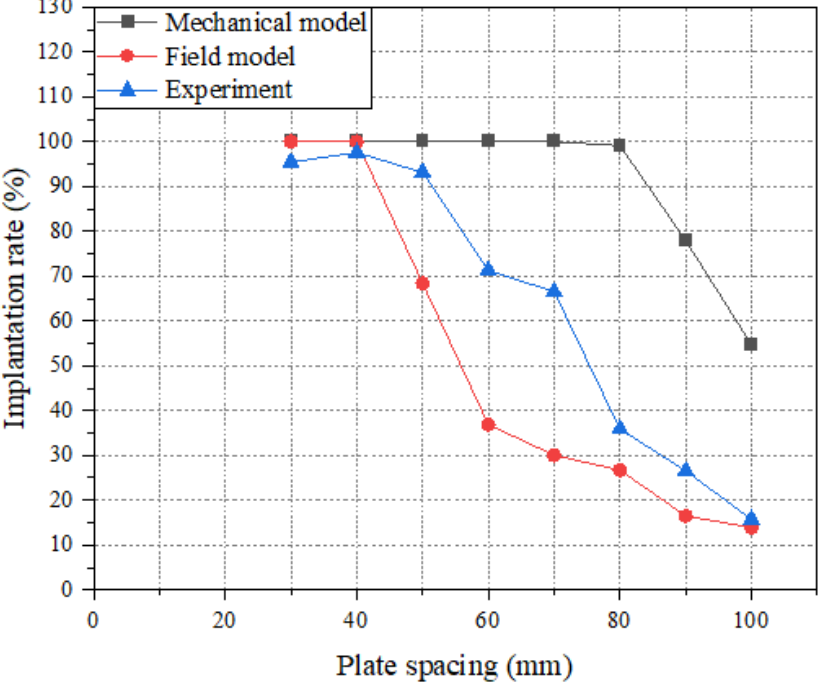
Figure 15. Comparison of the number of particles at different plate spacing.